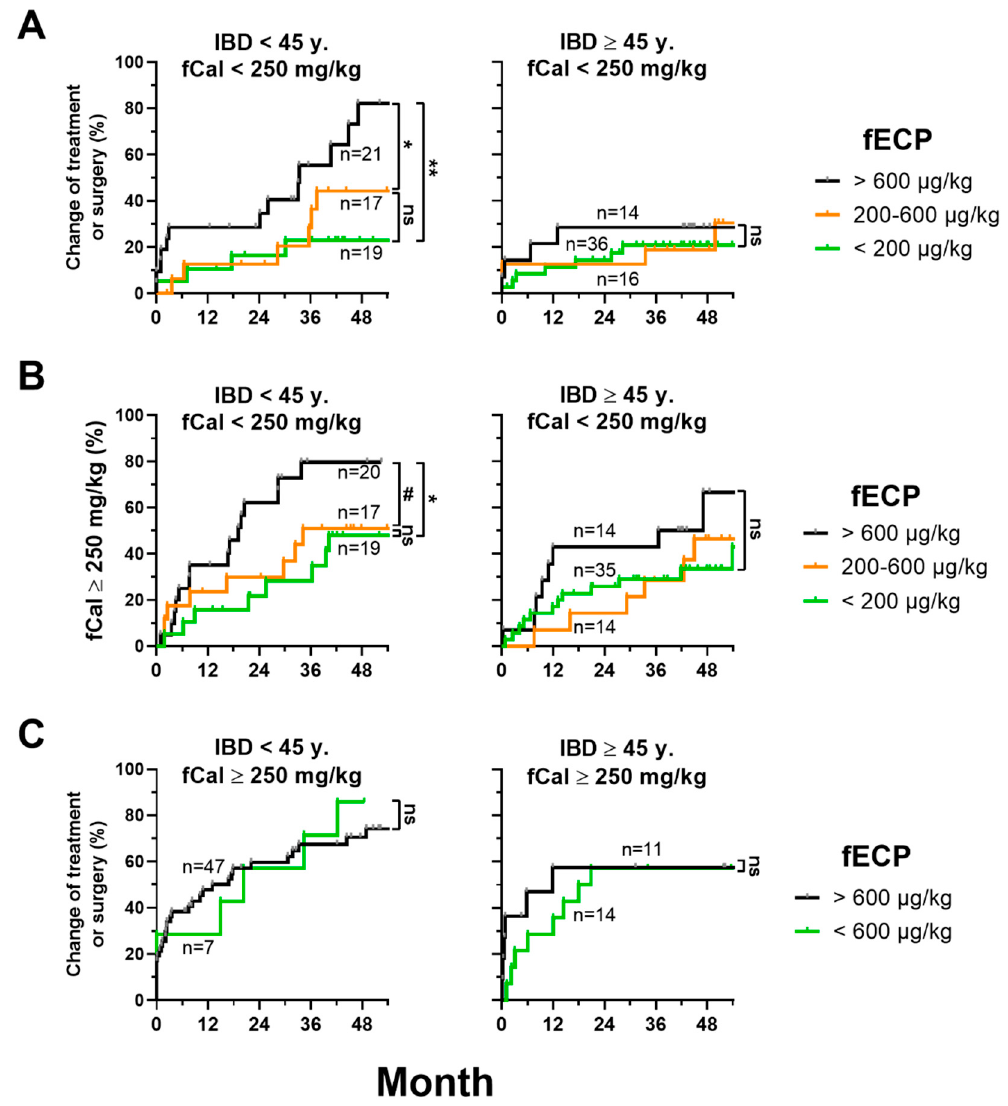
Figure 3. fECP is a predictive marker in young patients with IBD and with low inflammatory activity. ( A ) Inverse Kaplan–Meier curves as in Figure 2 including only patients with fCal levels <250 mg/kg at baseline. ( B ) Inverse Kaplan–Meier for the time to the first fCal measurement ≥ 250 mg/kg during follow-up including the same patients as in (A) depending on different levels of fECP at baseline. ( C ) Inverse Kaplan–Meier for treatment modification or surgery depending on different fECP levels at baseline including only patients with fCal levels ≥ 250 mg/kg at baseline. P-values were calculated with log-rank (Mantel–Cox) test. ns (non-significant), p > 0.07; #, p ≤ 0.07; *, p < 0.05; **, p < 0.01; ***, p < 0.001.